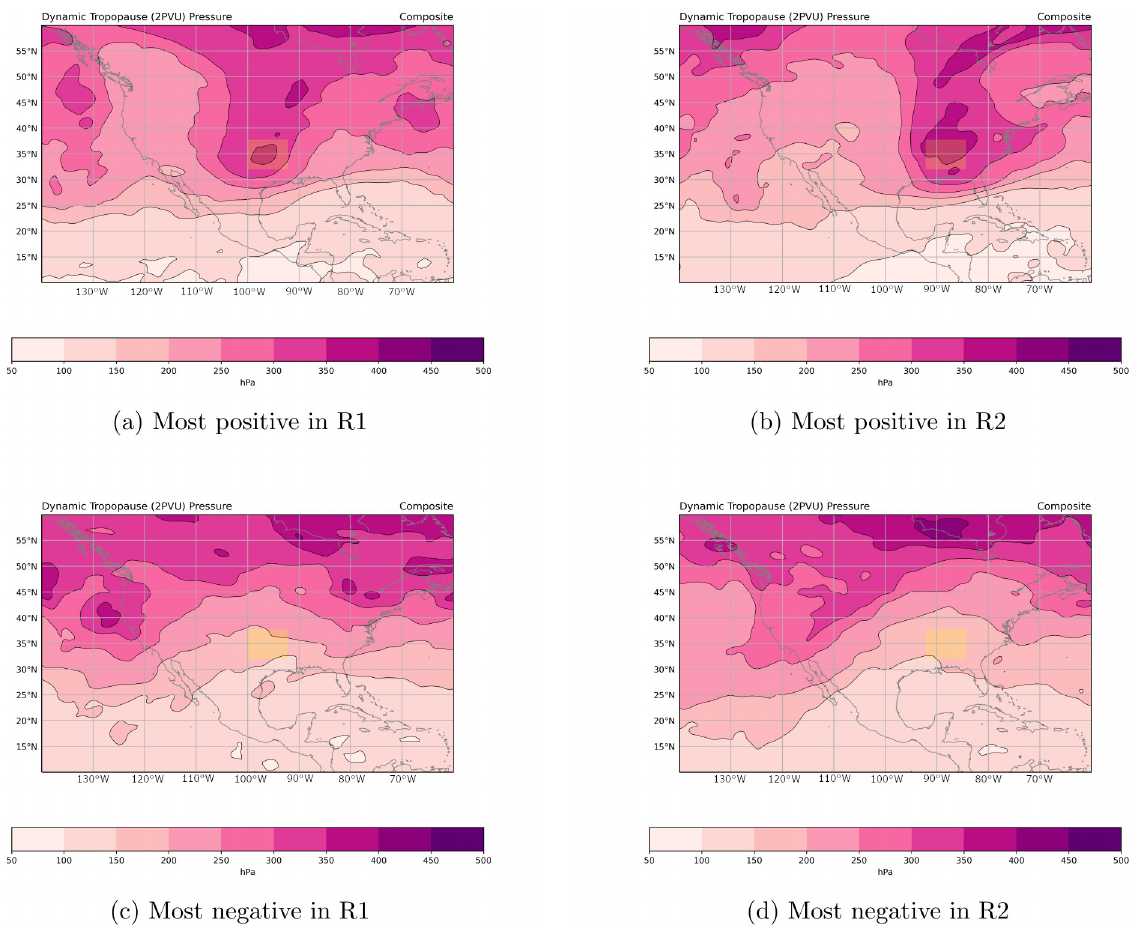
Fig 3. Composite maps of dynamical tropopause (2 PVU surface) pressure associated with the stratospheric forcing (STF) mode for times corresponding to (a) the ten most positive values in R1, (b) the ten most positive values in R2, (c) the ten most negative values in R1 and (d) the ten most negative values in R2. The yellow-shaded box is the corresponding study